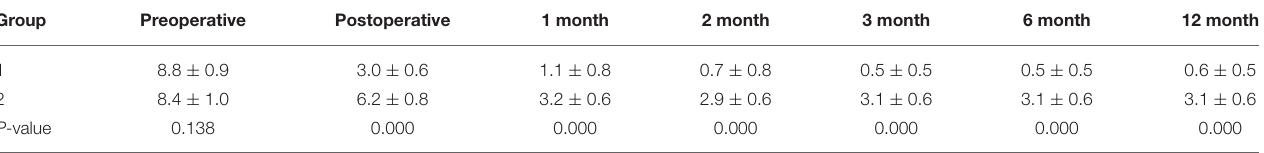
TABLE 2 | VAS pain assessment of the two groups.